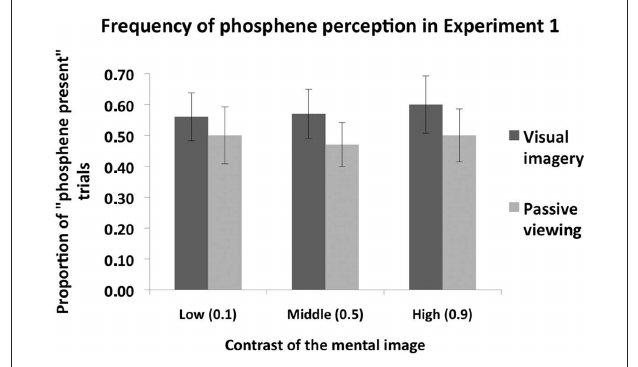
Figure 2 | The mean ( n = 8) proportion of “Phosphene present” judgments as a function of stimulus contrast (0.1, 0.5, or 0.9) and task condition (imagery vs. Passive viewing), collapsed over the three response types which indicate that a phosphene was perceived (i.e., “weak,” “almost clear” and “absolutely clear” on the response scale). TMS was applied at phosphene threshold, which refers to the intensity at which phosphenes are perceived at 50% of trials (i.e., proportion of “phosphene present” trials is 0.5). Overall subjects perceived more phosphenes in the Visual imagery condition compared to the Passive viewing condition. However, grating contrast had no impact. Error bars represent ± 1